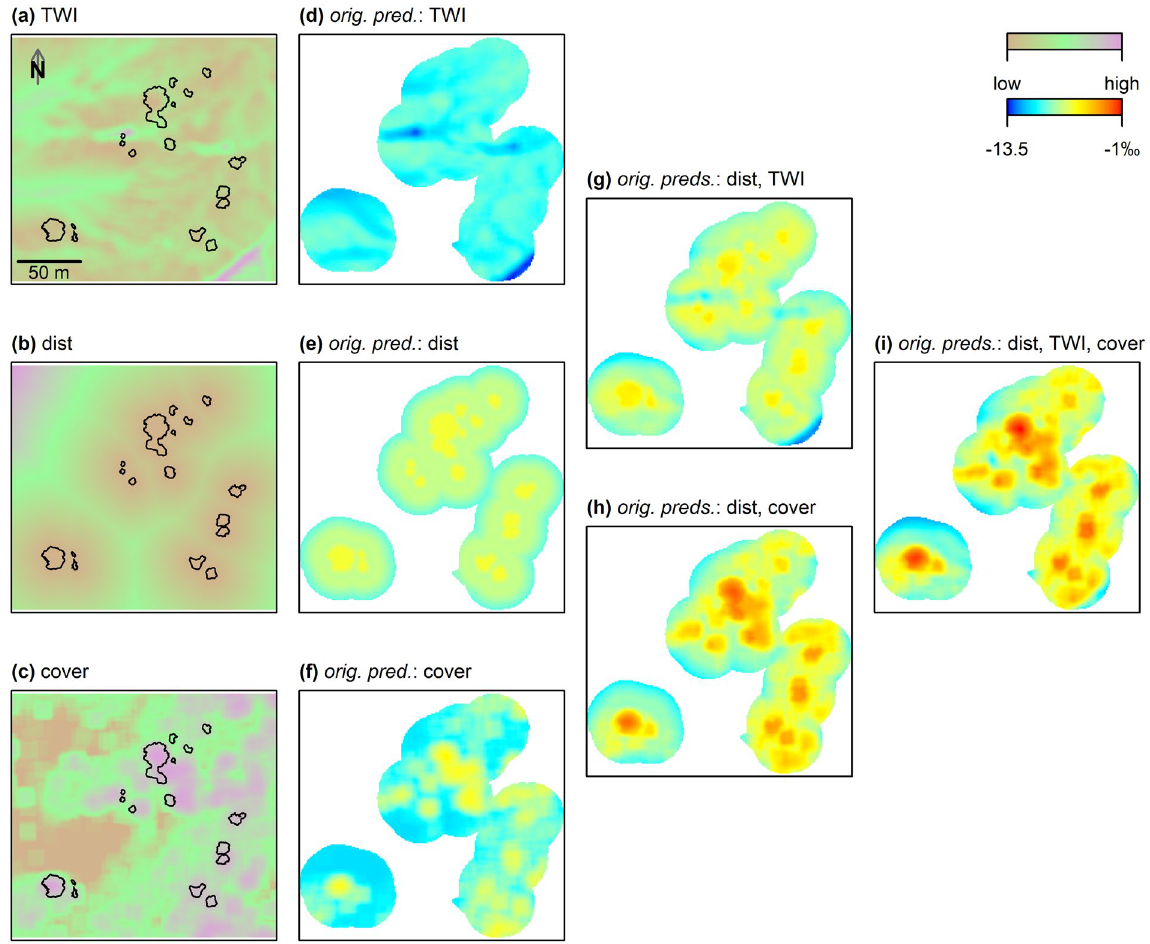
Figure 4. Model simulations illustrating the additive effects of three selected spatially explicit predictors on model estimates for the study site Pinheiro da Cruz. ( a–c ) Raster maps of the predictors TWI (topographic wetness index), dist (distance to the closest Acacia longifolia canopy) and cover (log(vegetation cover + 1)) are shown. Black outlines demarcate A . longifolia canopies. ( d–i ) Model simulations of Corema album foliar δ 15 N using a generalized additive mixed model (GAMM) with six predictors (including TWI, dist and cover , see Methods section for details). Predictors specified in the panel heading are included with their original spatial variation while all other predictors are held constant at their mean (for continuous predictors) or at the most frequent class (for factors). First, only one predictor was used with its original variation, with all other variables held constant ( d–f ), second, additive effects of two original predictors are illustrated ( g,h ), and finally, ( i ) shows the combined effect when taking into account the spatial variation of three